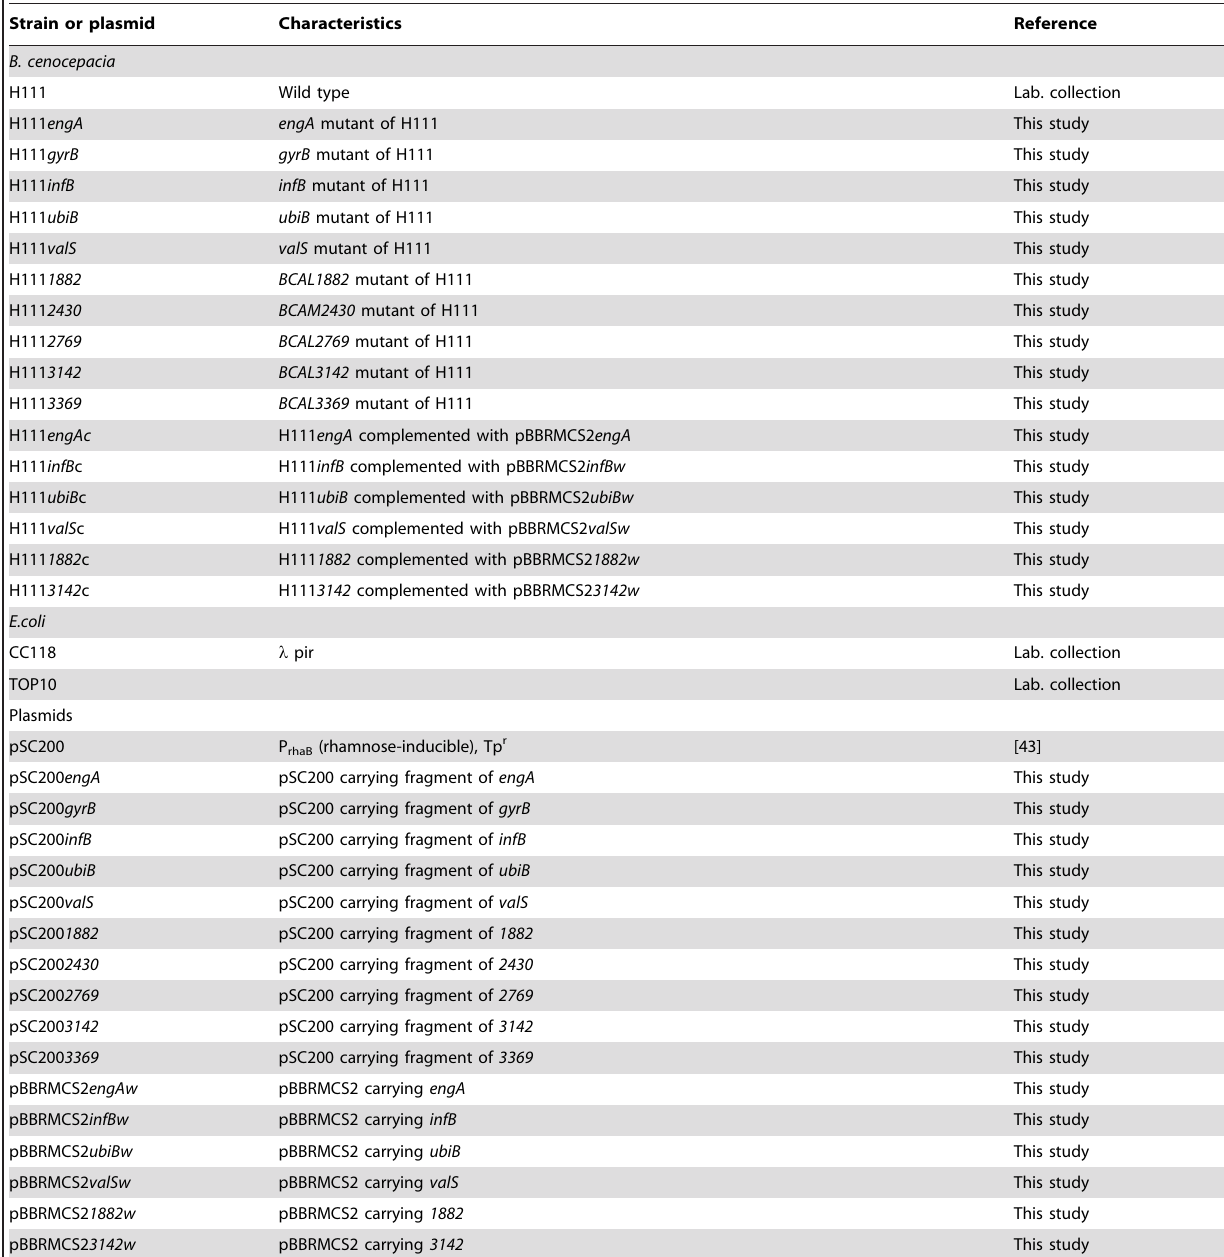
Table 1. Bacterial strains and plasmids used in this